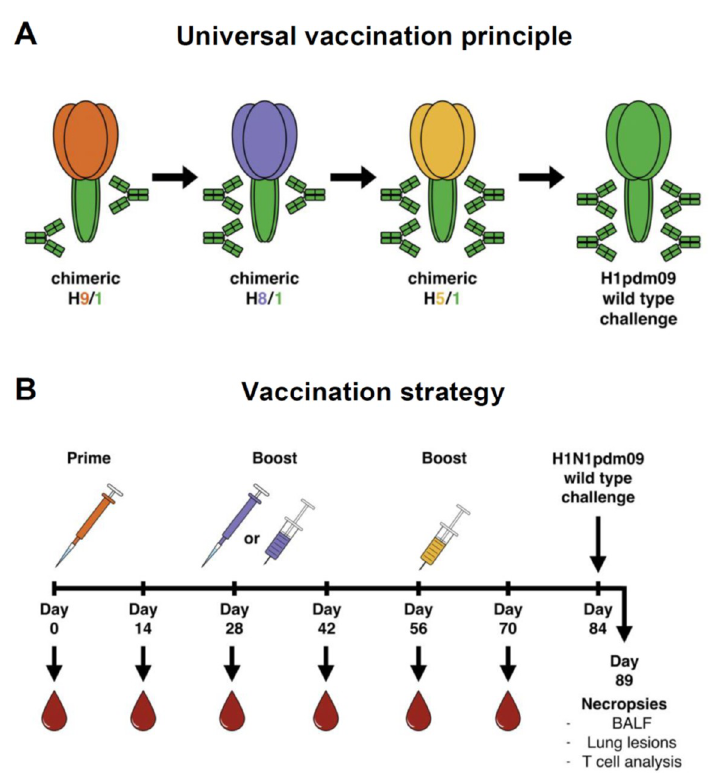
Figure 1. Study overview. ( A ) The universal vaccination principle is based on raising stalk HA antibodies by sequential vaccination with influenza vaccines containing HA heads of different influenza subtypes grafted on a conserved HA stalk. ( B ) Schematic representation of the experimental layout. Pipette symbol represents intranasal administration, syringe represents intramuscular injection.